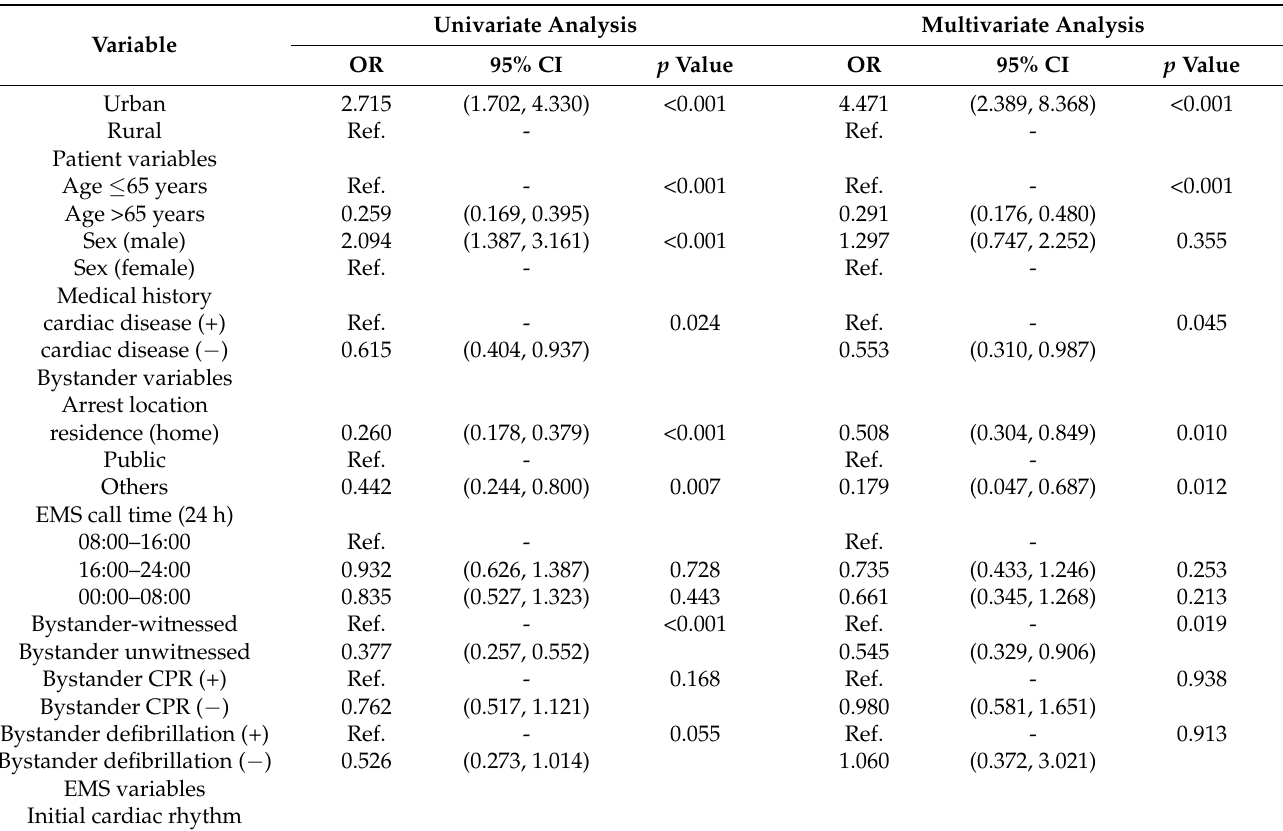
Table 3. Factors associated with survival to discharge after OHCA in the total study